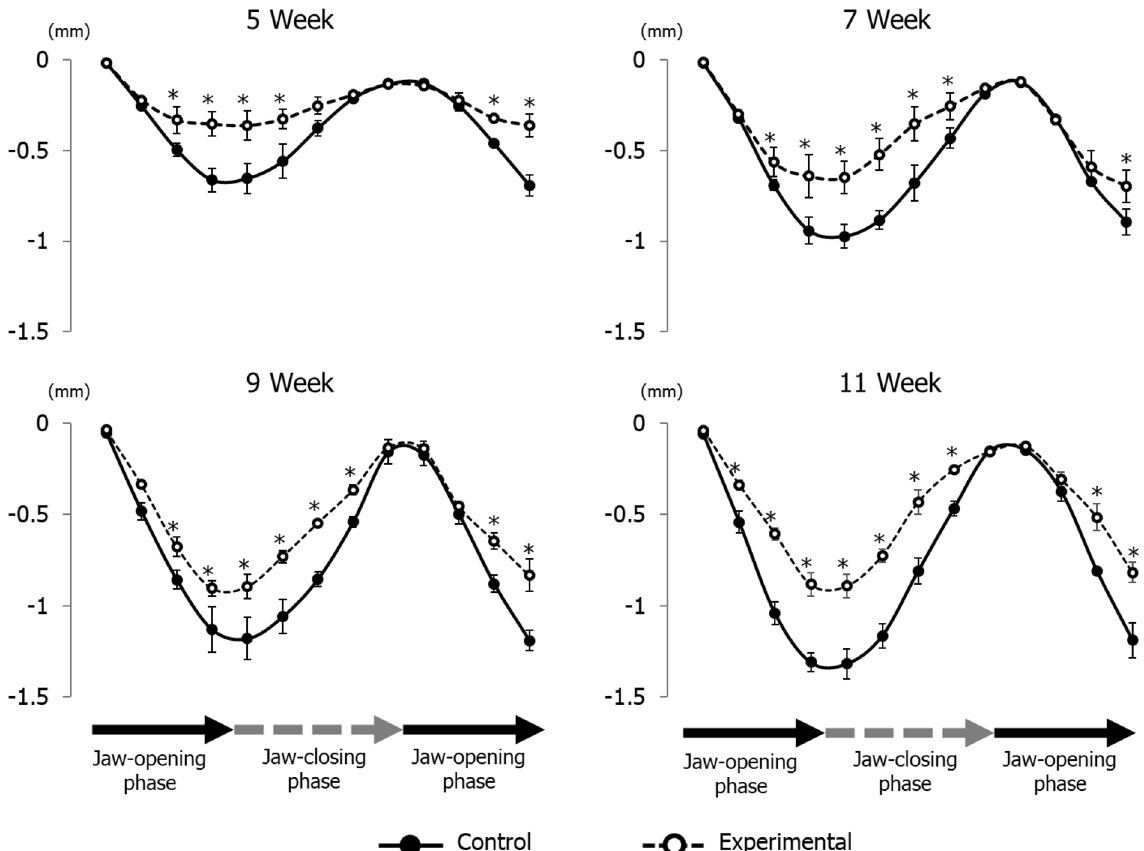
Figure 6. Longitudinal comparison of the path of vertical jaw movement between the control and experimental groups during jaw-opening and closing phases. The 13 points mark the 10 ms intervals throughout the masticatory cycle. Data are displayed as mean ± standard deviation. *p < 0.05 denotes significant differences between the control and experimental